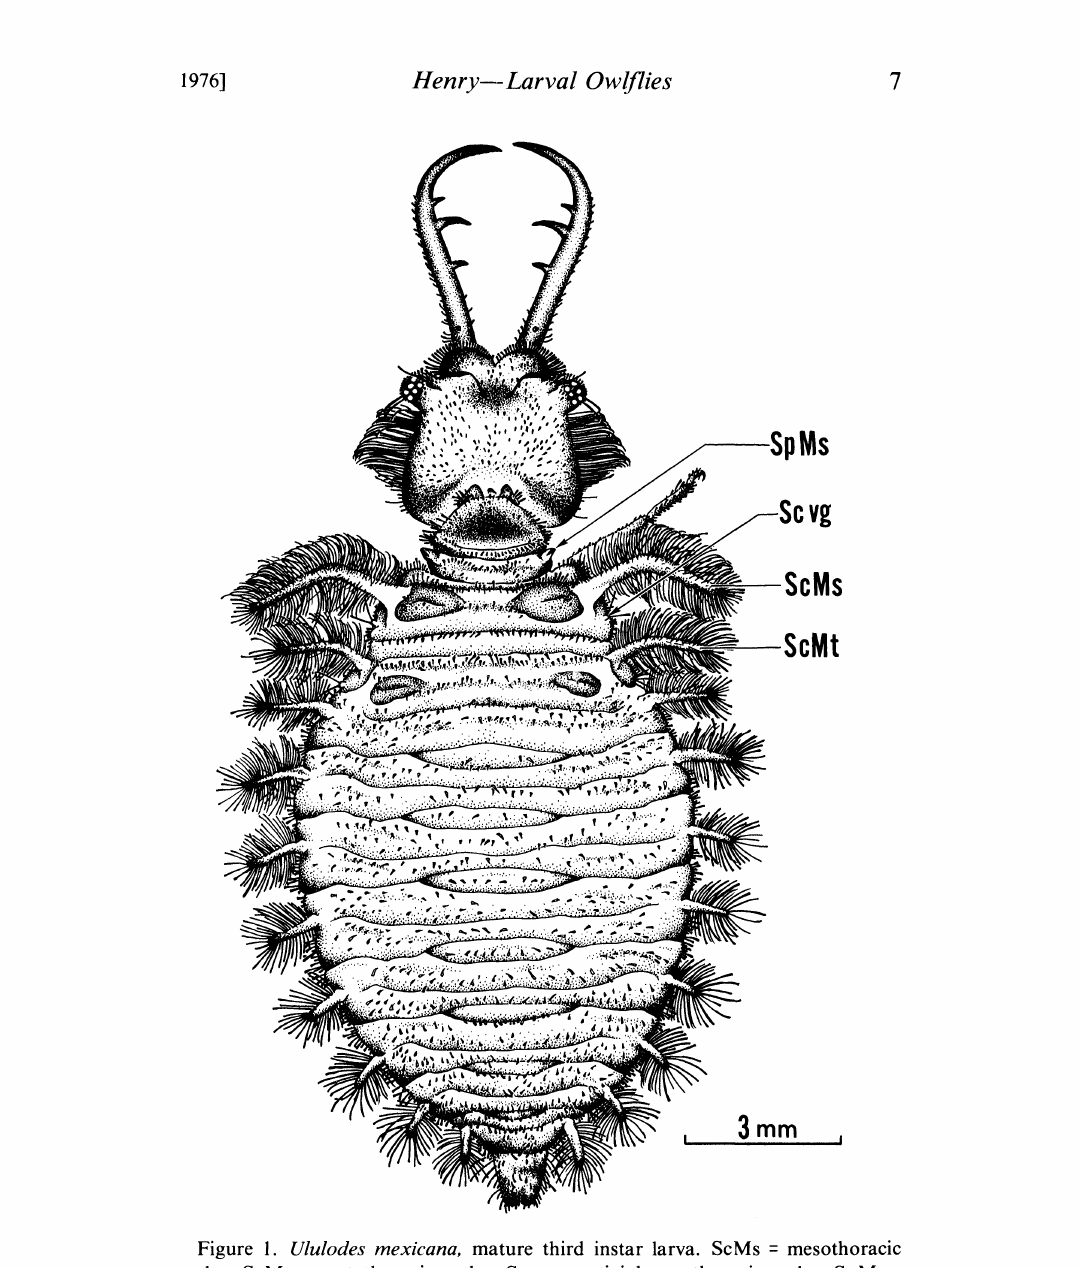
Figure 1. Ululodes mexicana, mature third instar larva. ScMs mesothoracic scolus, ScMt metathoracic scolus, Scvg vestigial mesothoracic scolus, SpMs mesothoracic